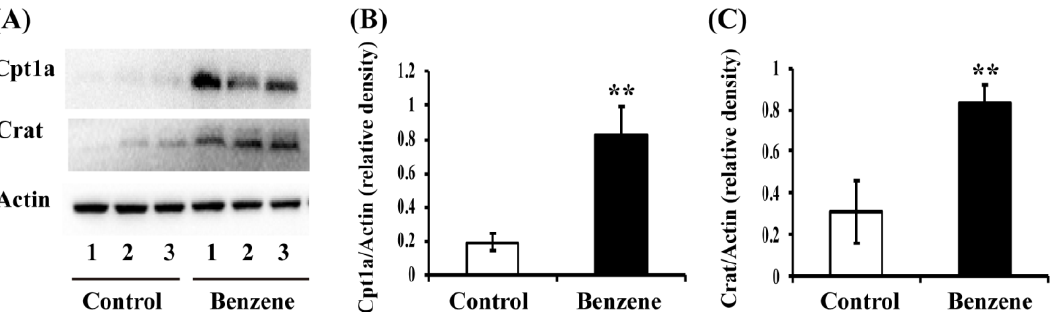
Figure 3. Benzene induces increased expression of key fatty acid (FA) transport proteins in mouse BM cells. Male C3H/He mice were exposed to benzene for 4 weeks, and BM cells were collected. Then, Cpt1a and Crat protein levels were detected by Western blot ( A ). The relative expression of Cpt1a ( B ) and Crat ( C ) was calculated by densitometric scanning of band intensity. Values are mean ± SD; ** p < 0.01, compared with control group.